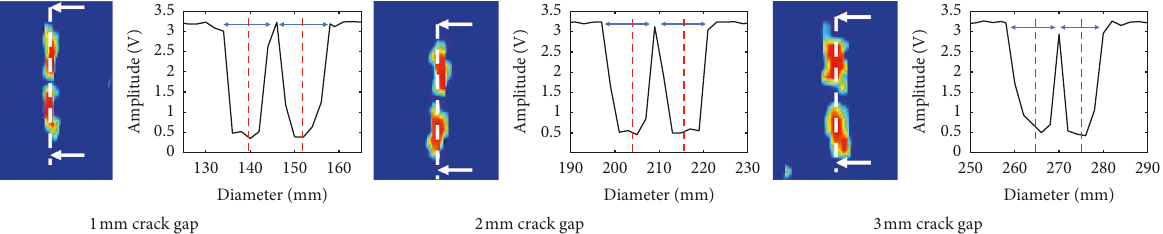
Figure 20: Inspection results for 10mmV-double type crack: C-scan (left) and cross section amplitude